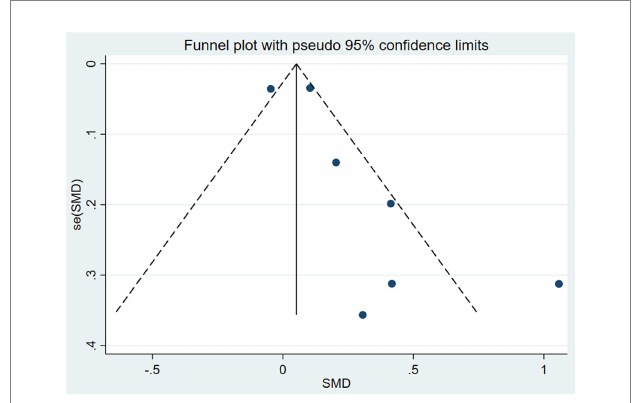
FIGURE 7 Funnel plot of studies using MMSE as cognitive evaluation.